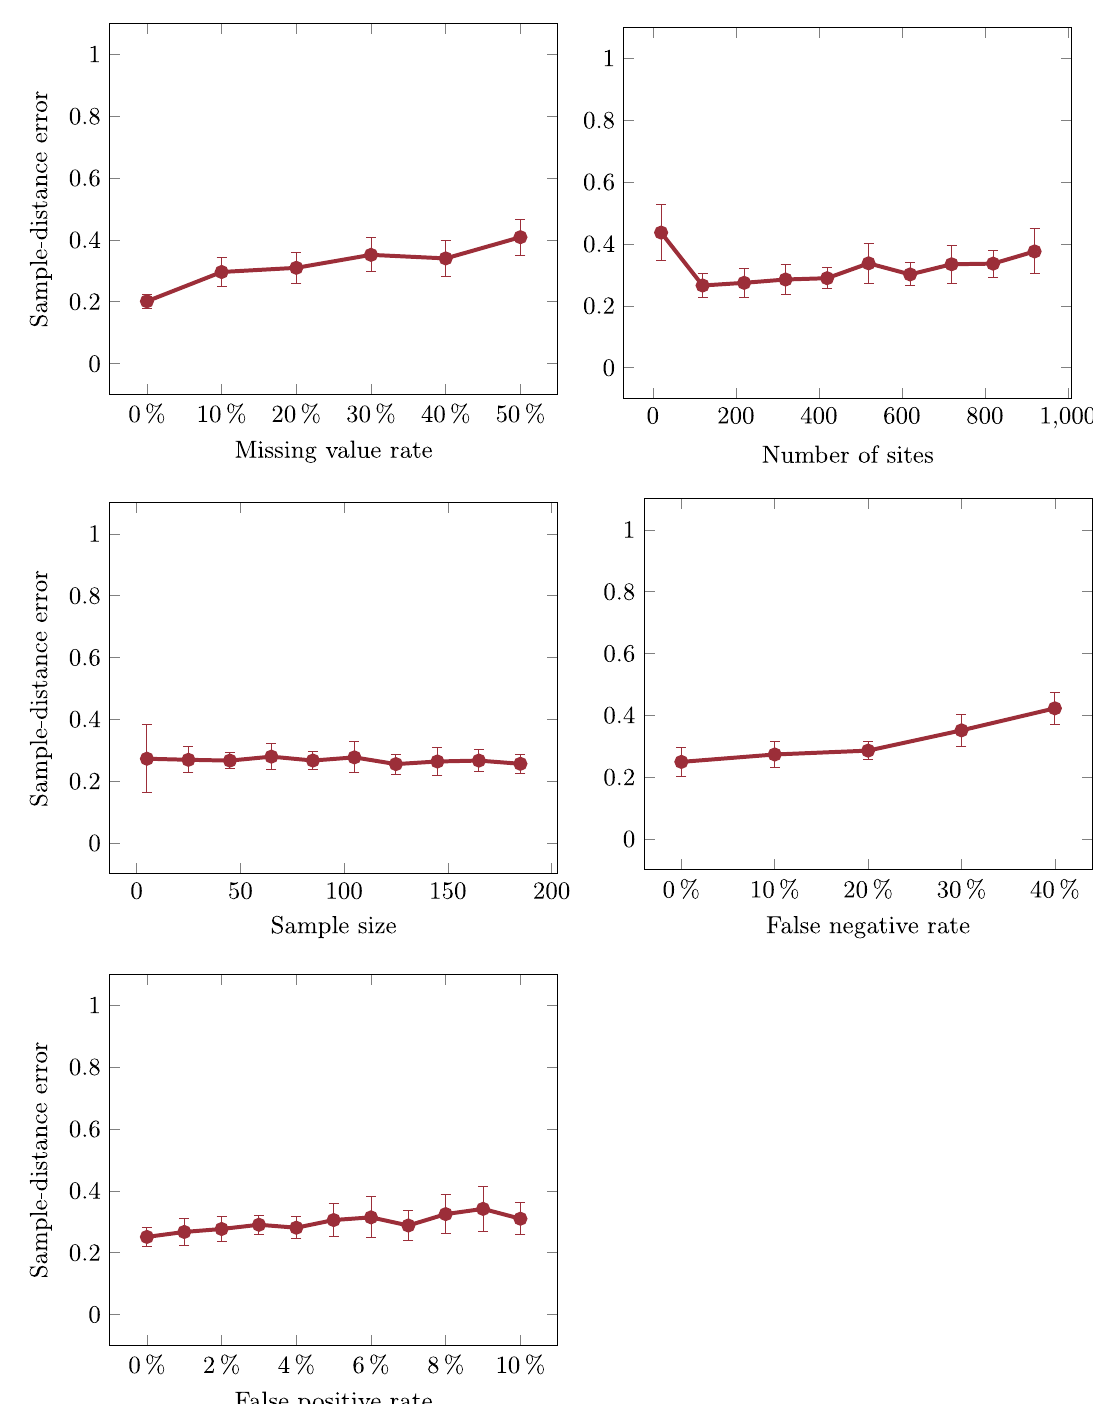
Fig 3. Robustness of Scelestial to variation in the properties of ground truth lineage trees in terms of sample distance in the trees between the inferred and ground truth trees.